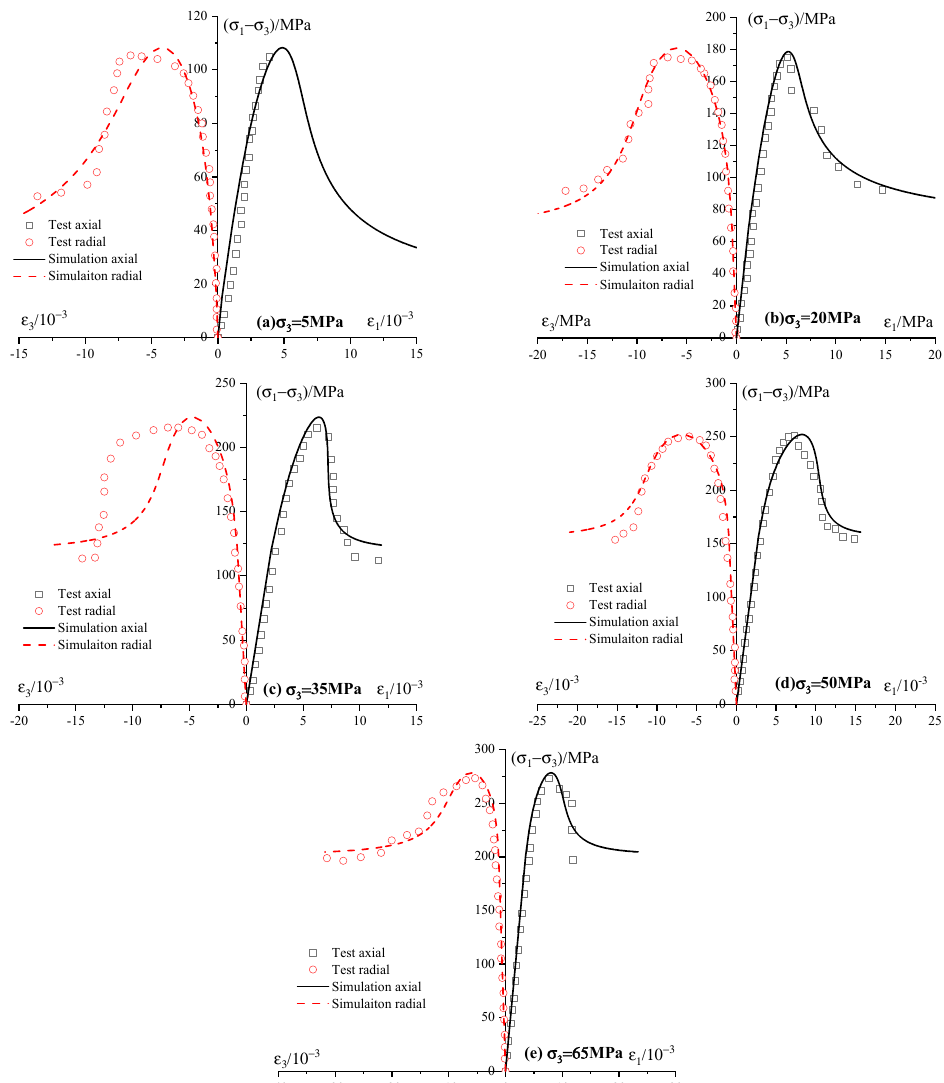
Table 5. Model’s parameters for Shandong sandstone.